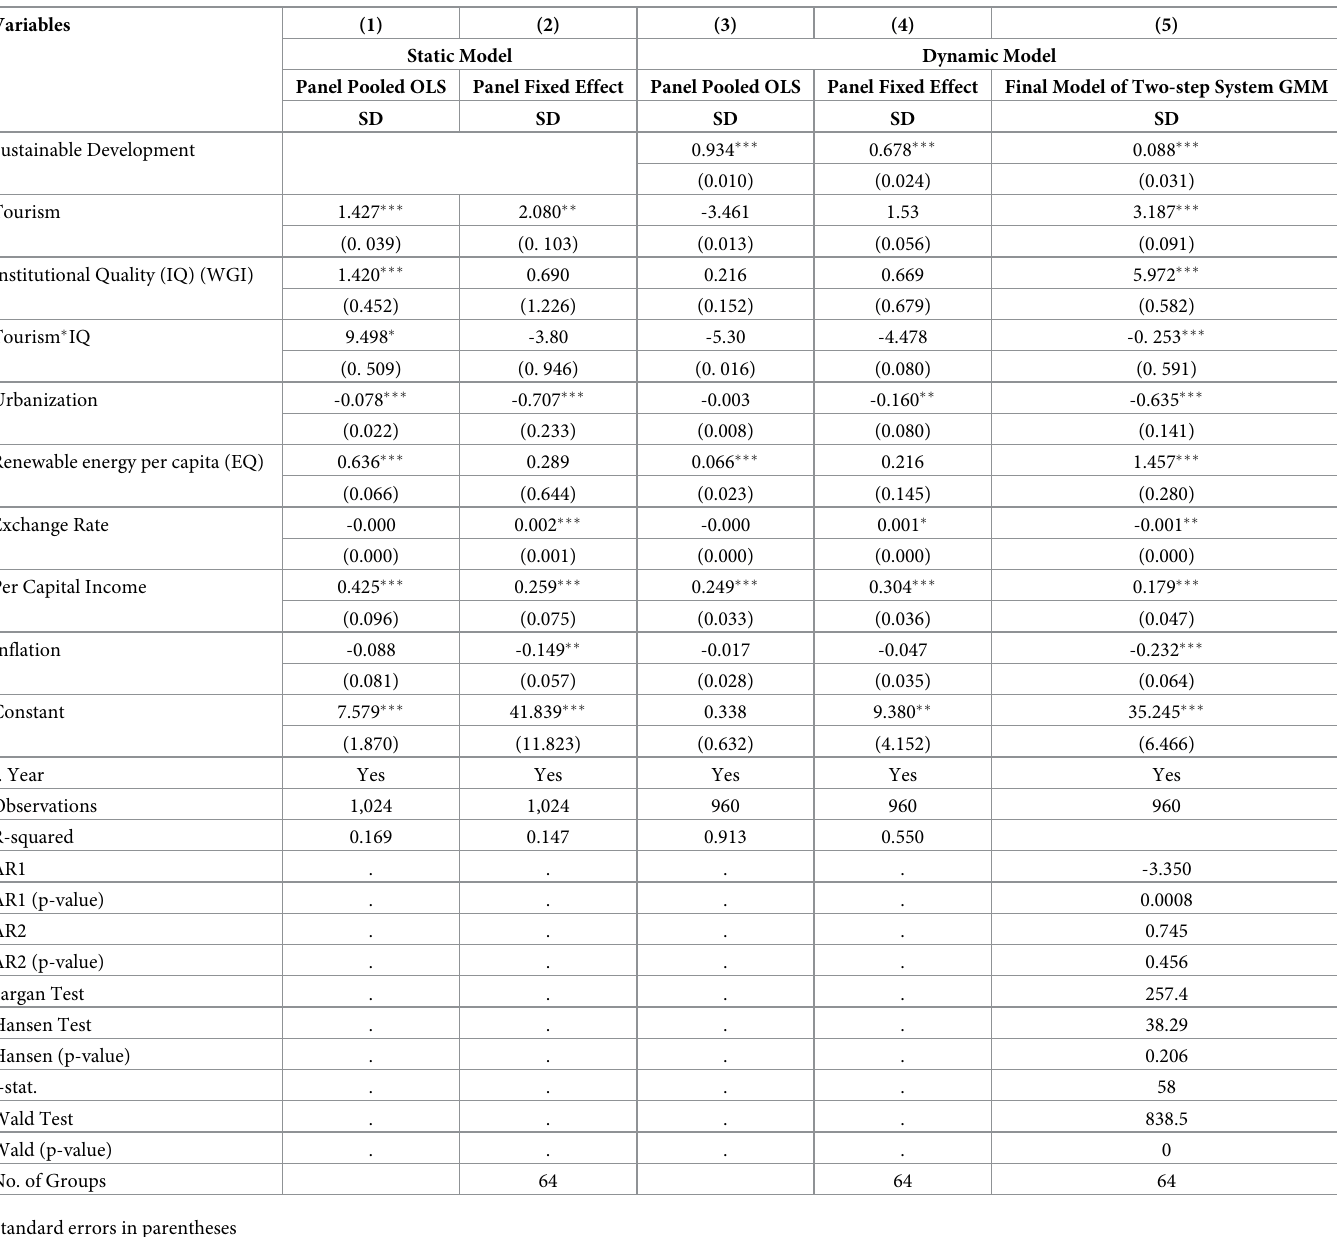
Table 8. Robustness check results of moderating impact of IQ between tourism and SD.